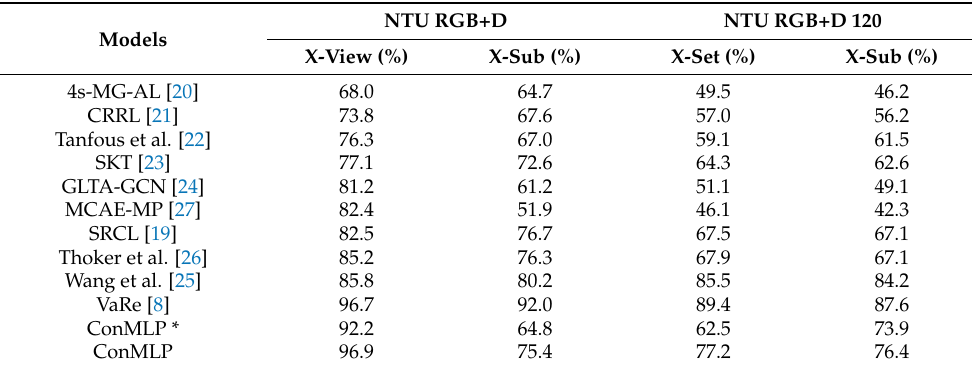
Table 2. Top 1 accuracy comparison with self-supervised